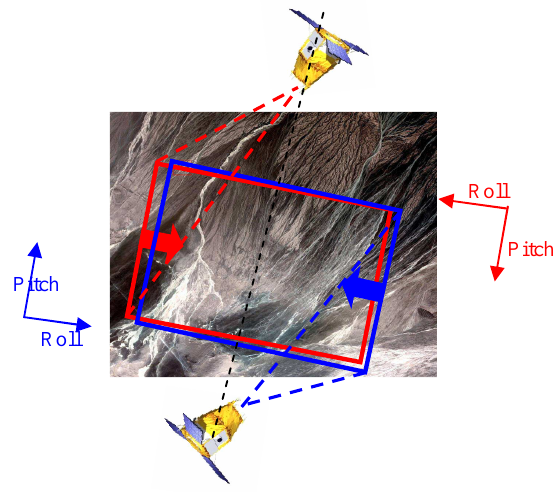
Figure 2 : “Auto-Reverse” acquisition principle